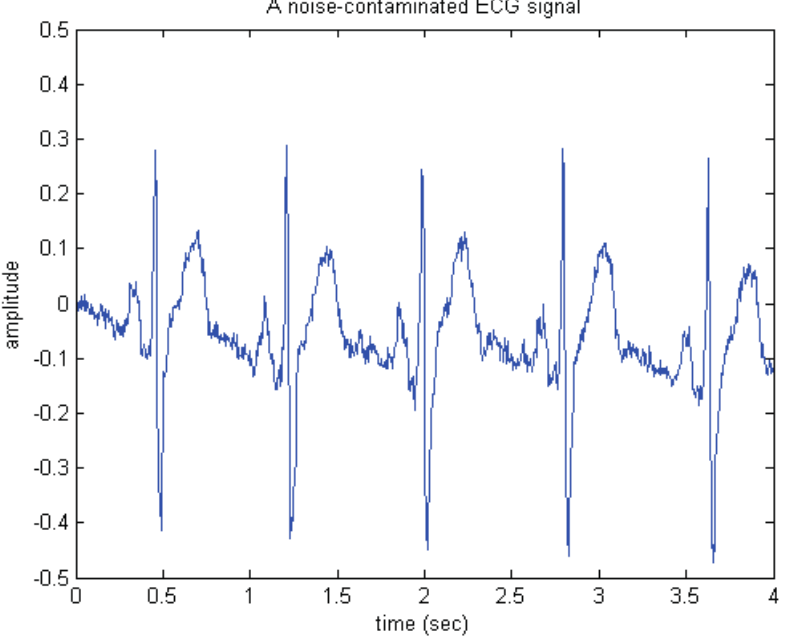
Figure 10. A simulated noise-contaminated electrocardiogram (ECG)